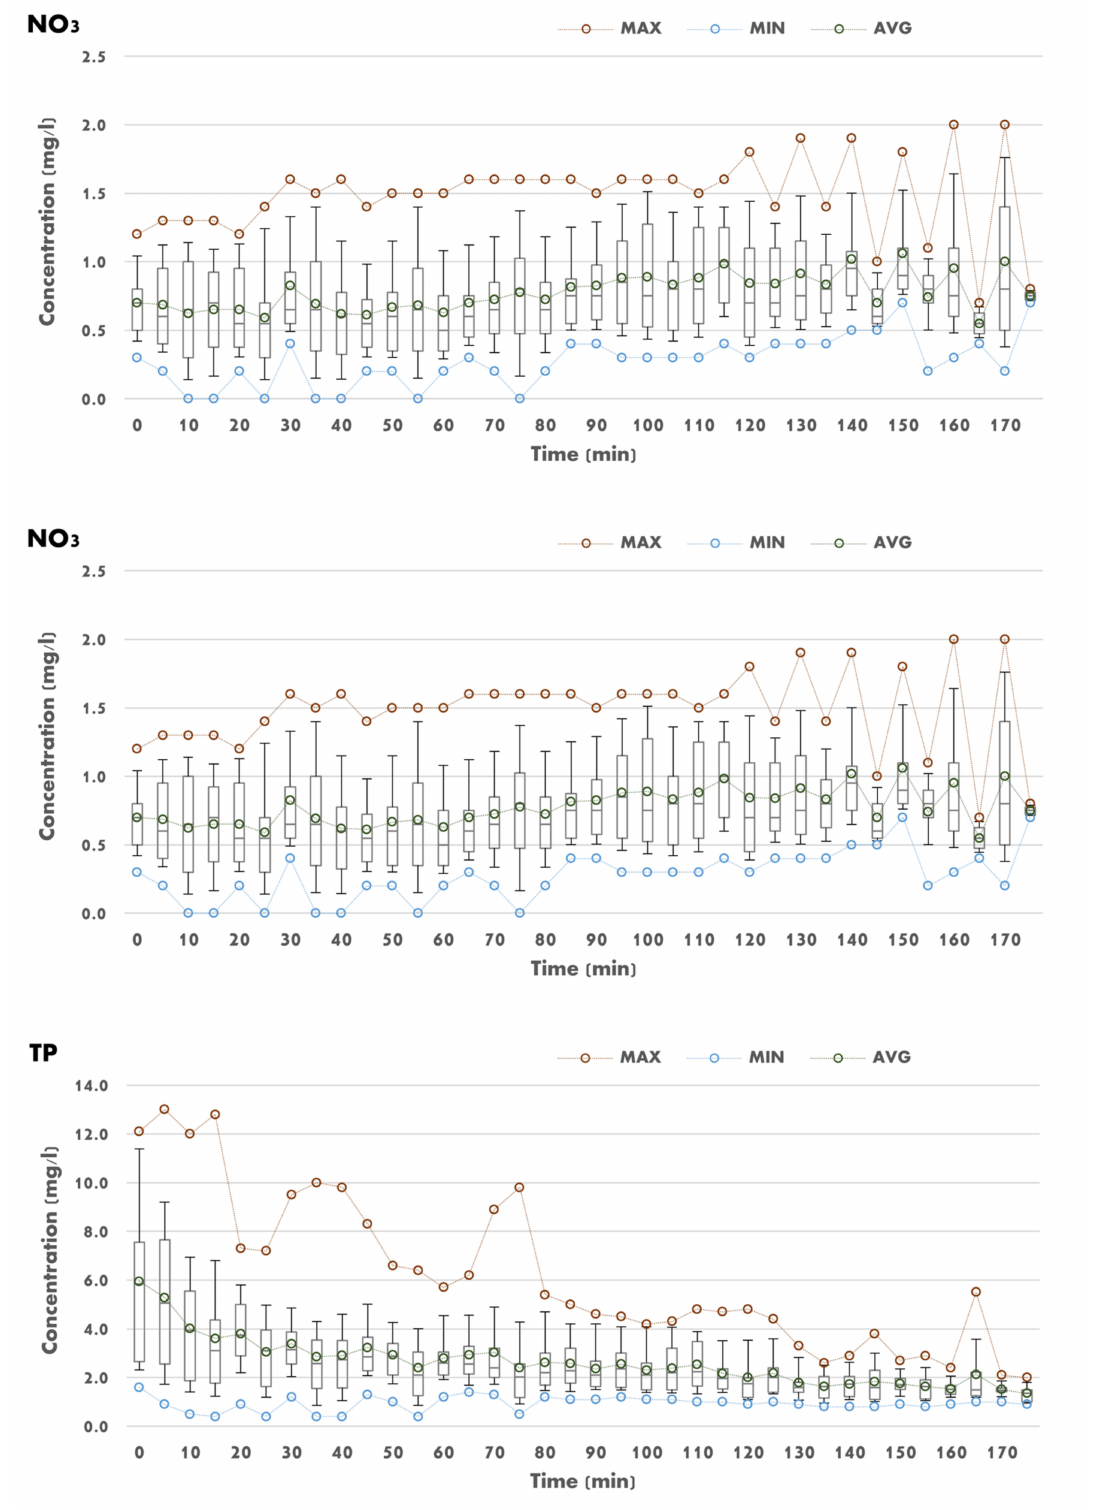
Figure A1. Moving (time) boxplot charts for BOD, KJN, NH 4 , NO 3 , NO 2 , and TP (5 min time step) for 1400+ samples retrieved in 5 Flemish